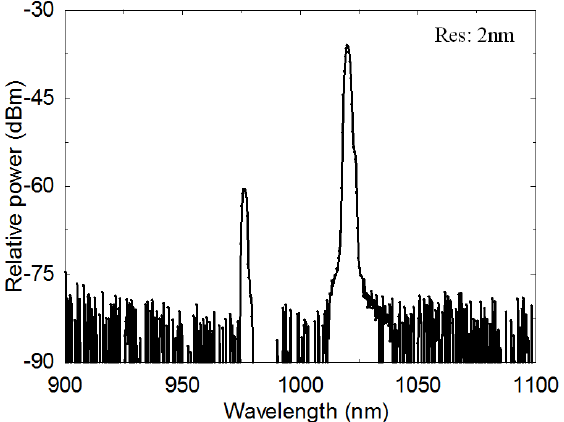
Figure 4. Experimental FRL output spectrum at 20 W of laser output power from 1.5 km of GRIN